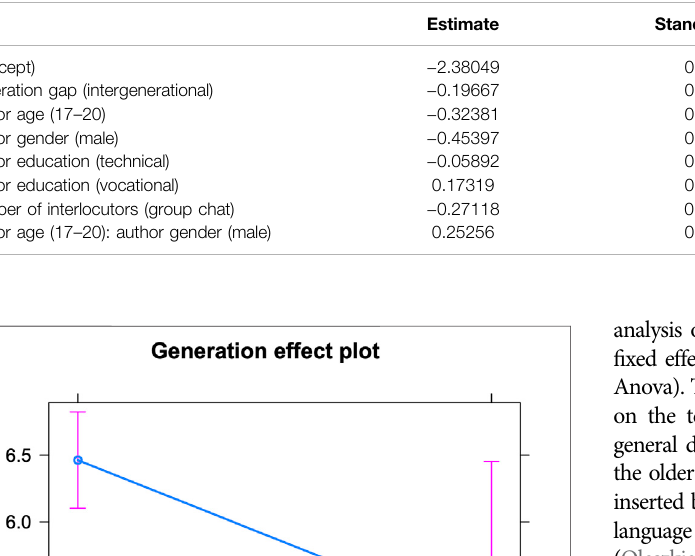
TABLE 3 | Expressiveness: Fixed effects 8 .